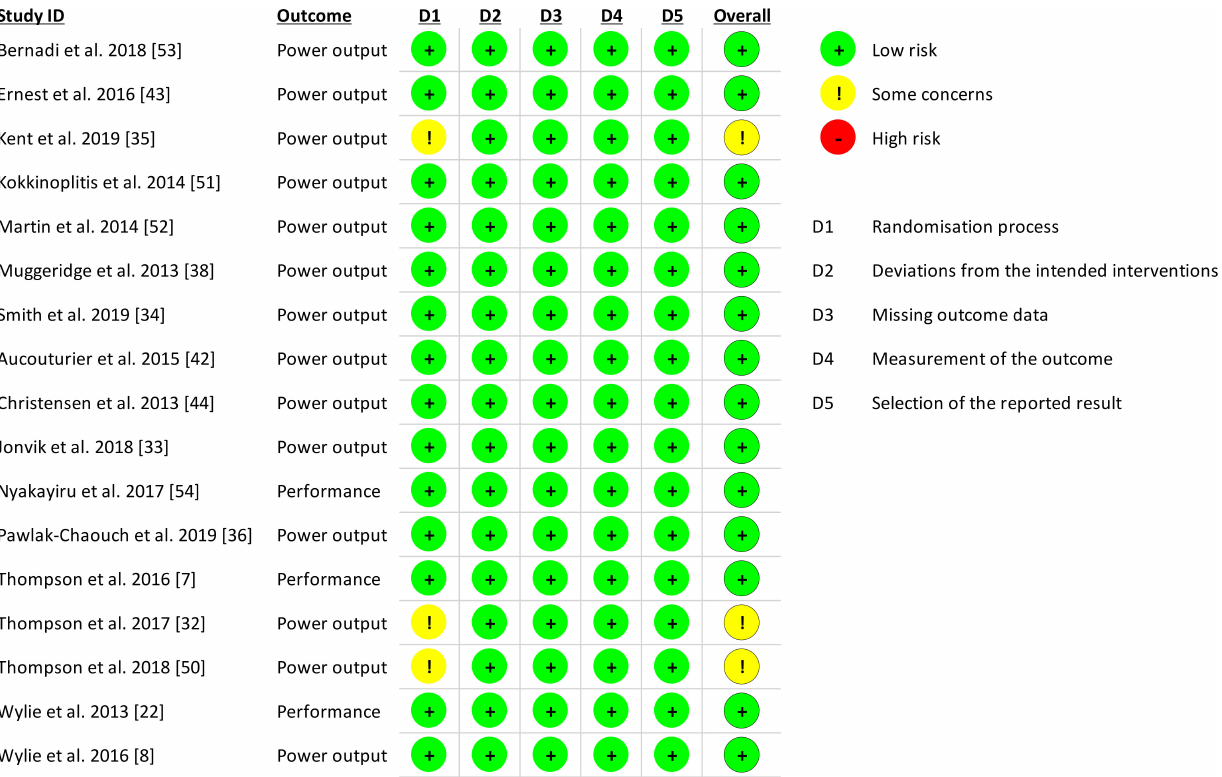
Figure A2. Summary of the risk of bias over five domains for the 17 included studies [7,8,22,32–36,38,42–44,50–54].